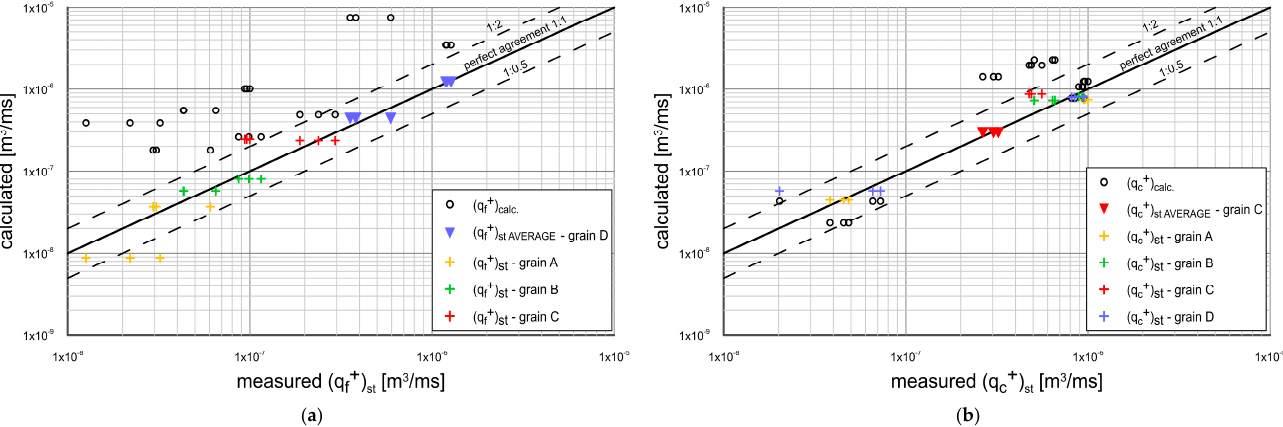
Figure 10. Comparison of calculated and measured transport during the crest q + in ( a ) fine fractions q + and ( b ) coarse fractions q + c f